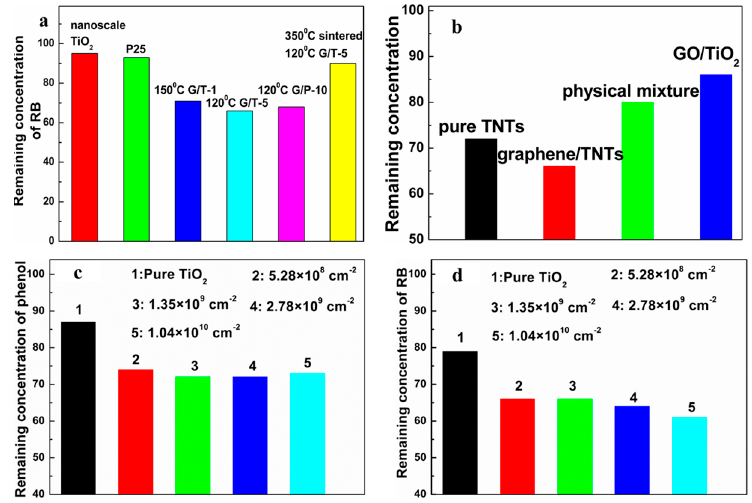
Figure 13. Relationship between adsorption ability and ( a ) mass fraction of graphene (graphene-TNTs composites), Reproduced with permission [15]. Copyright 2011 Elsevier ( b ) various composites (graphene-TNTs, graphene oxide-TNTs and physical mixture), Reproduced with permission [15]. Copyright 2011 Elsevier ( c , d ) defect density of 3DGNs (3DGNs-TiO 2 composites). Reproduced with permission [3]. Copyright 2017 Elsevier The model pollutant is rhodamine-B in ( a , d ) and phenol ( b , c ).